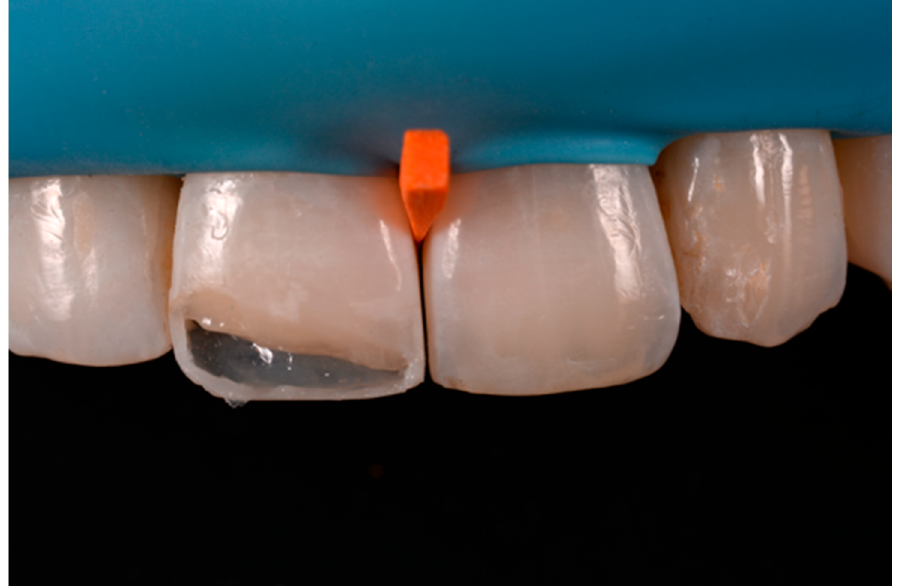
Figure 52. The frame completed.